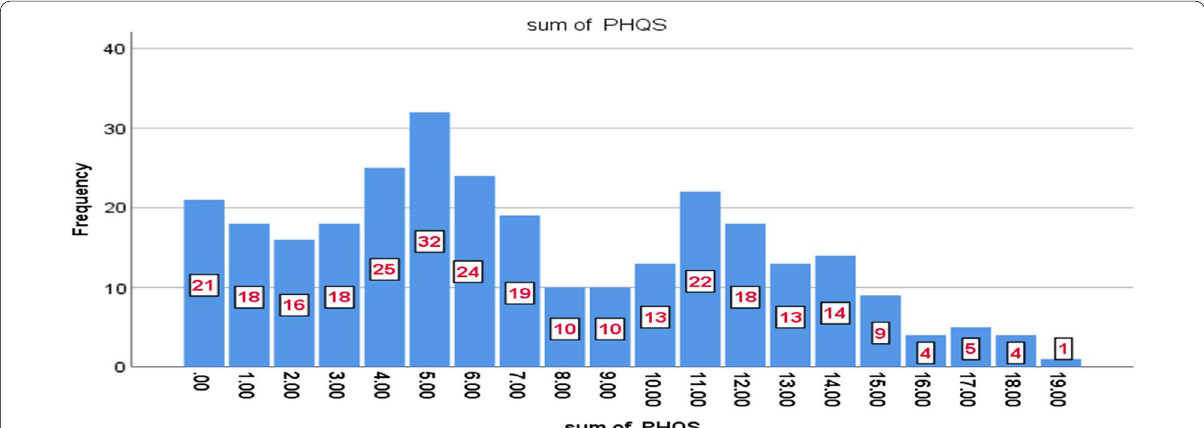
Fig. 1 The frequency of the sum of patient health questionnaire responses to the study depression and associated factors among PWE (n on follow-up at Ayder comprehensive specialized hospital and Mekelle hospital, Mekelle, Tigray, Ethiopia, 2019